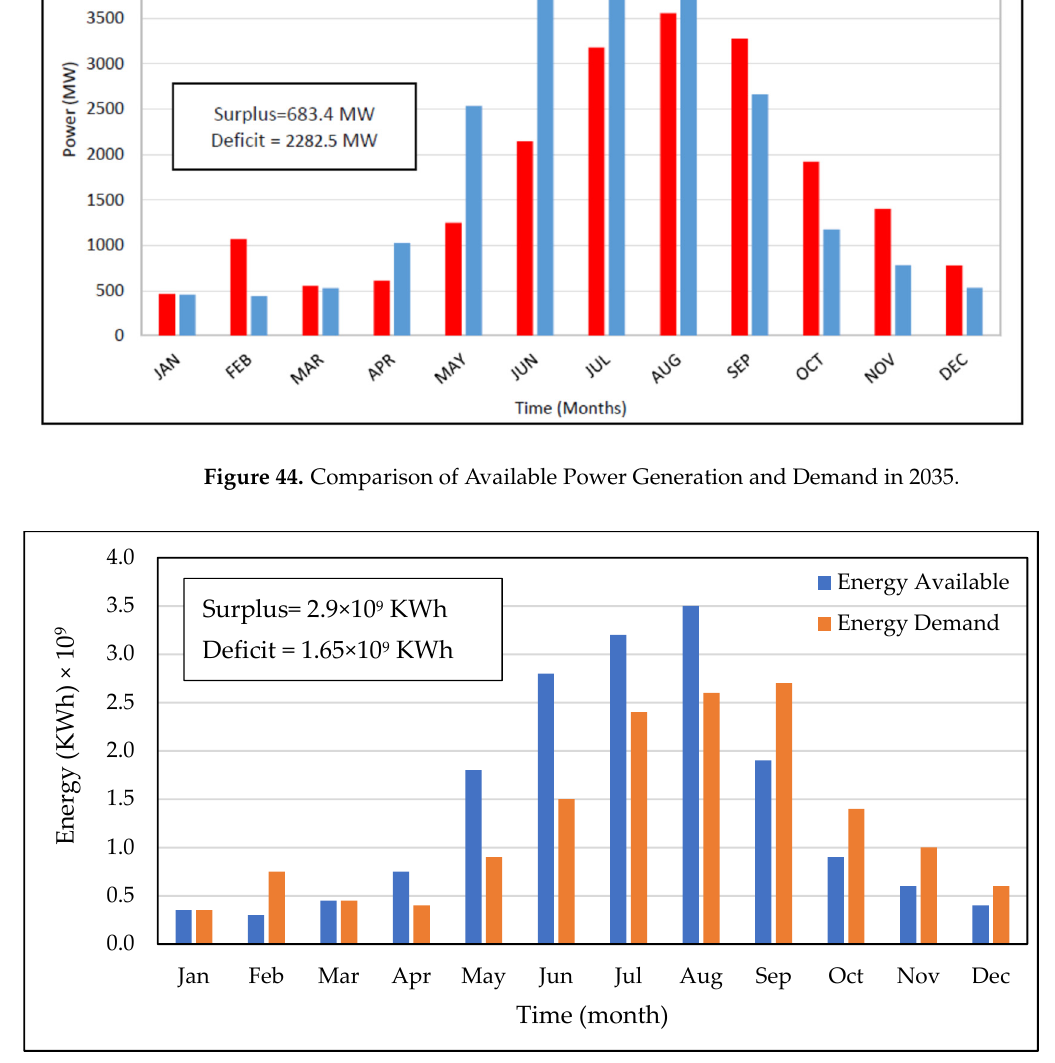
Figure 45. Comparison of Available Energy Generation and Demand in 2035.